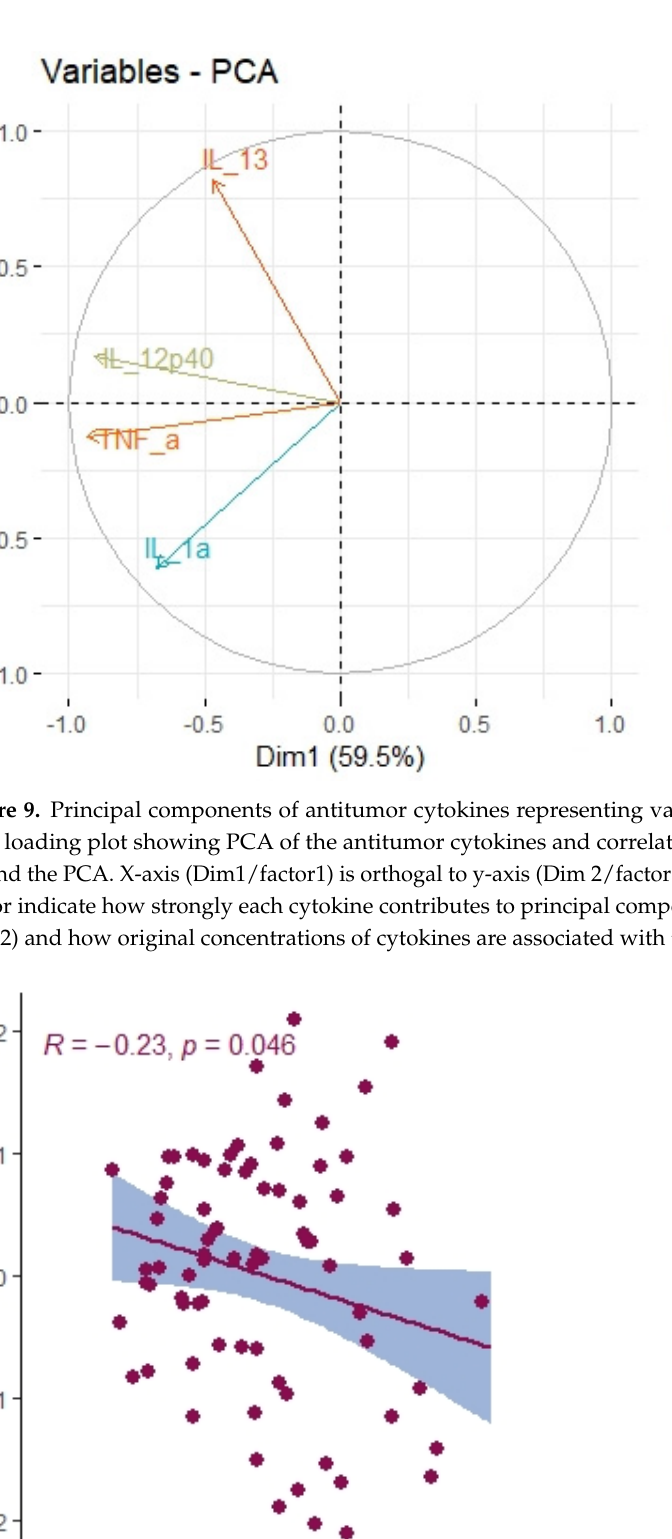
Figure 8. Scree plot of principal component analysis containing antitumor cytokines: IL-1a, IL-12, IL-13, TNF-a. Scree plot shows the proportion of overall variance explained by each individual prin- cipal component (factor).